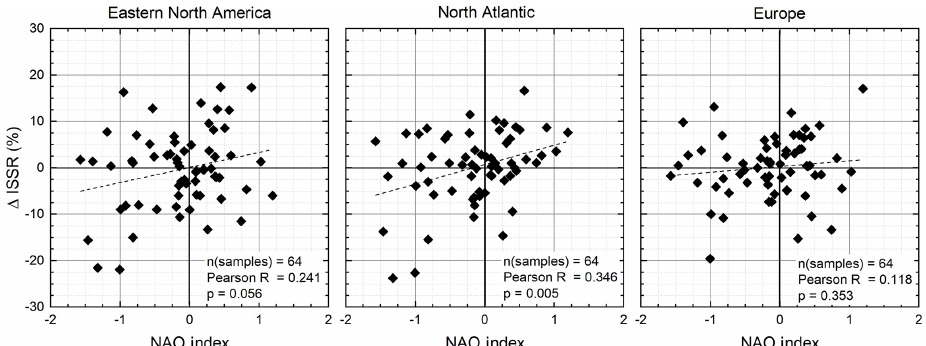
Figure 16. Correlation analysis with respect to the correlation of signs between NAO index and deviation of ISSR occurrence from the long-term average ( (cid:49) ISSR) for the target regions. Numbers indicate the results from the correlation analysis with respect to number of samples n , Pearson’s R and significance level p